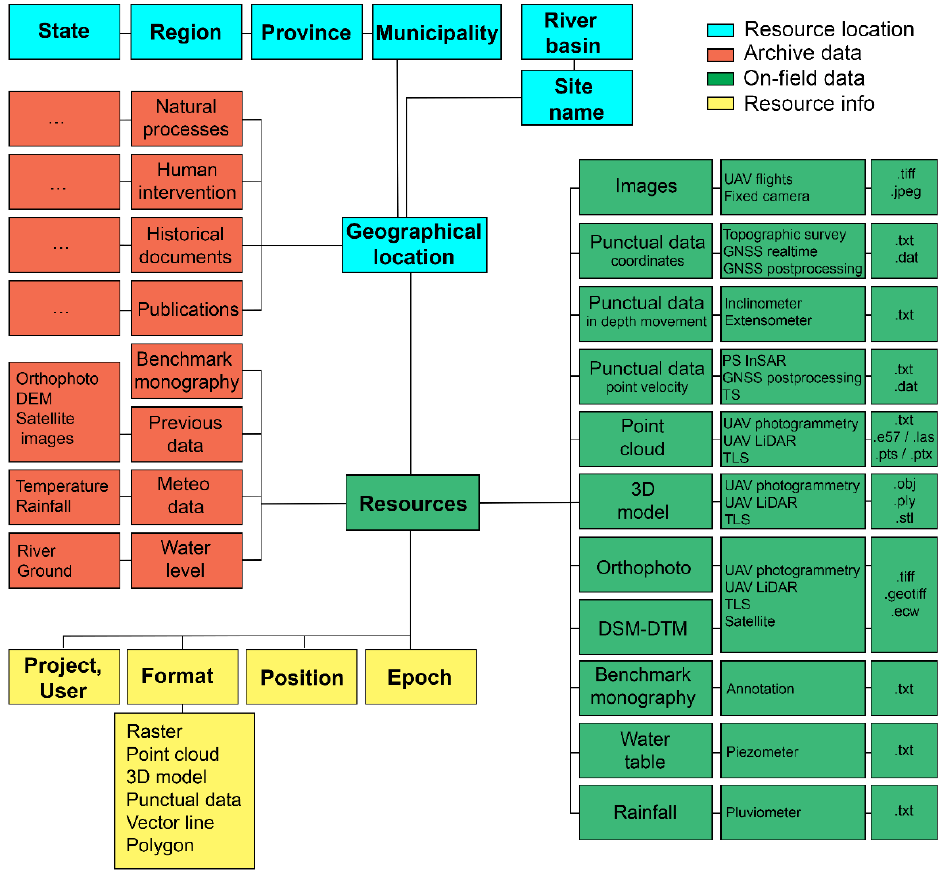
Figure 2. Schematic physical structure of an object-based relational and geometric database.